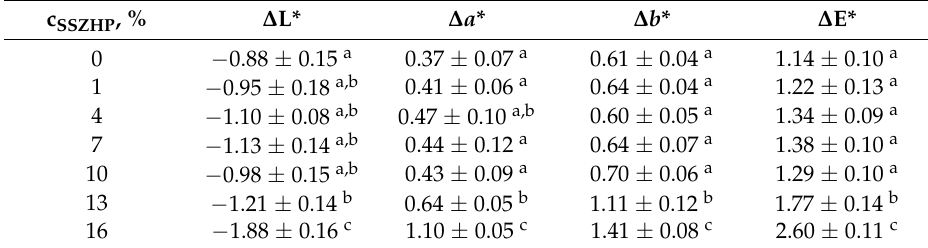
Table 4. The color changes of different composites after